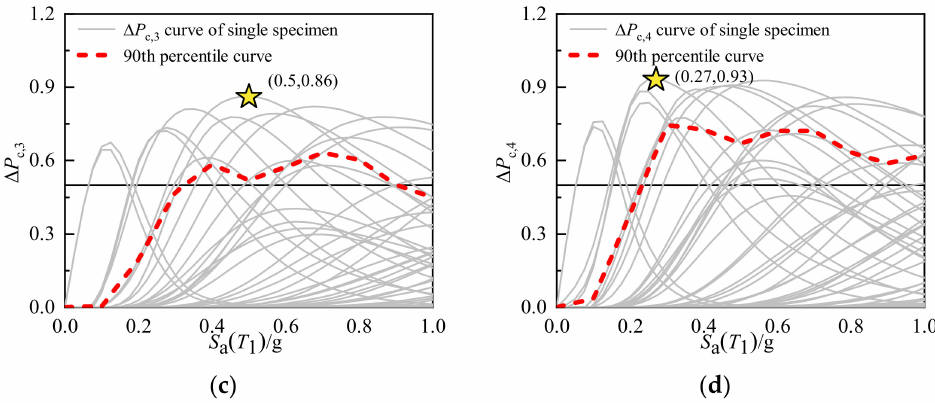
Figure 8. Results of ∆ P c,i for damaged column of different initial damage level. ( a ) Results of ∆ P c,1 . ( b ) Results of ∆ P c,2 . ( c ) Results of ∆ P c,3 . ( d ) Results of ∆ P c,4 . The red dotted lines in Figure 8 are the 90th percentile curves of ∆ P c,i . As